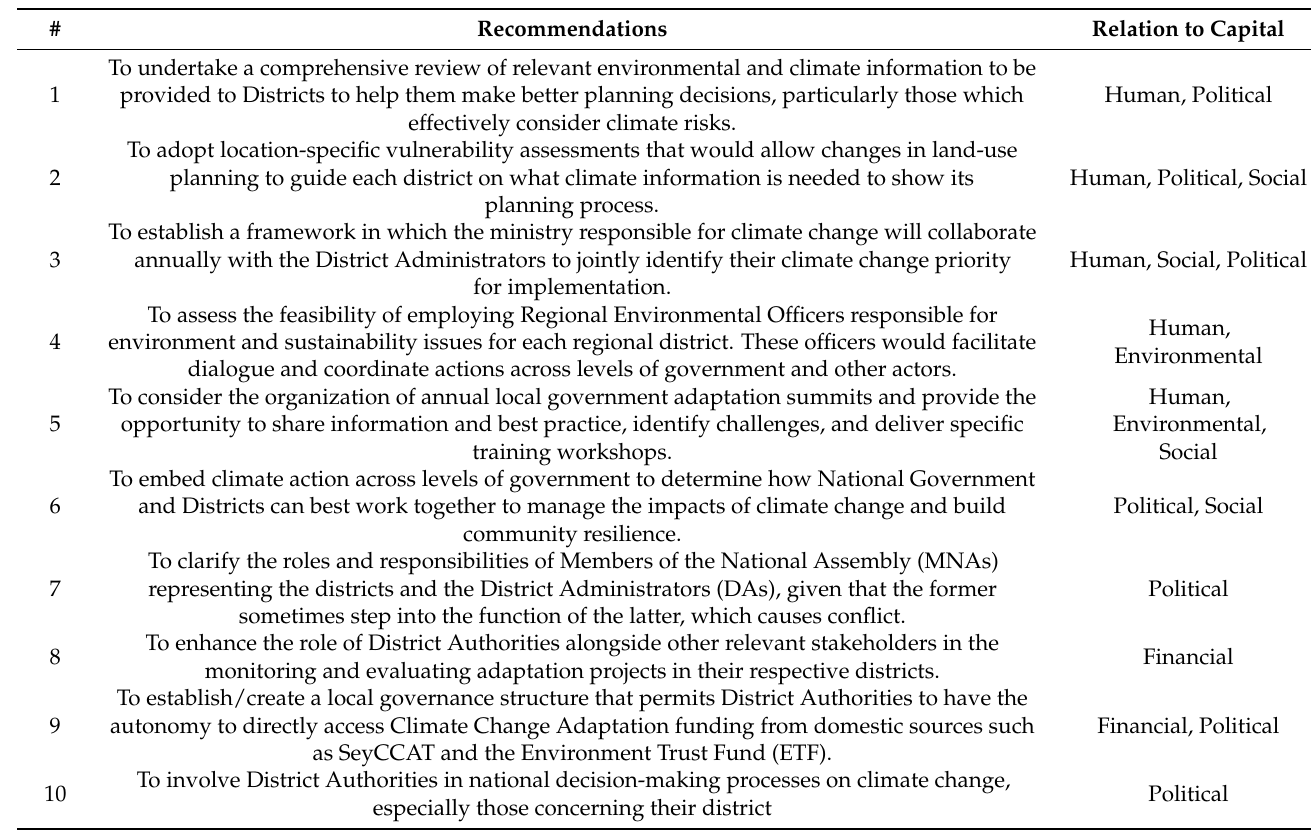
Table 1. Co-developed recommendations for policy measures in Seychelles and validated with climate change adaptation